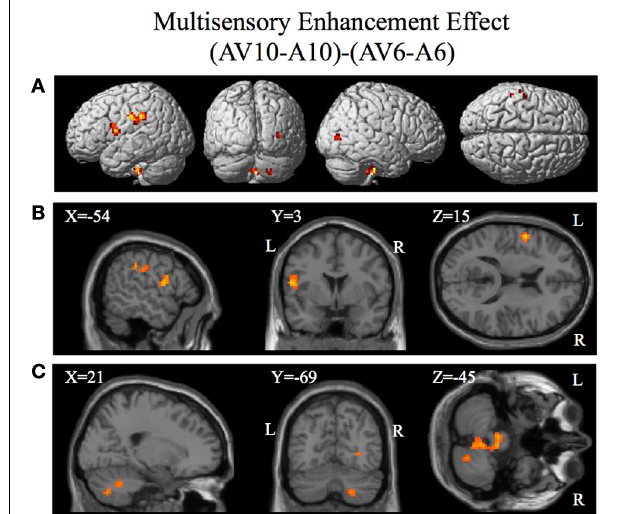
FIGURE 4 | Significant brain activity for the combined AV conditions thresholded at pFDR < 0.05 corrected. Activity was present in left and right PMvi/Broca’s area, left PMvs/PMd, left and right STG/S including primary and secondary auditory cortex, left MT/V5 visual motion processing area, and the right cerebellum lobule VIIb.